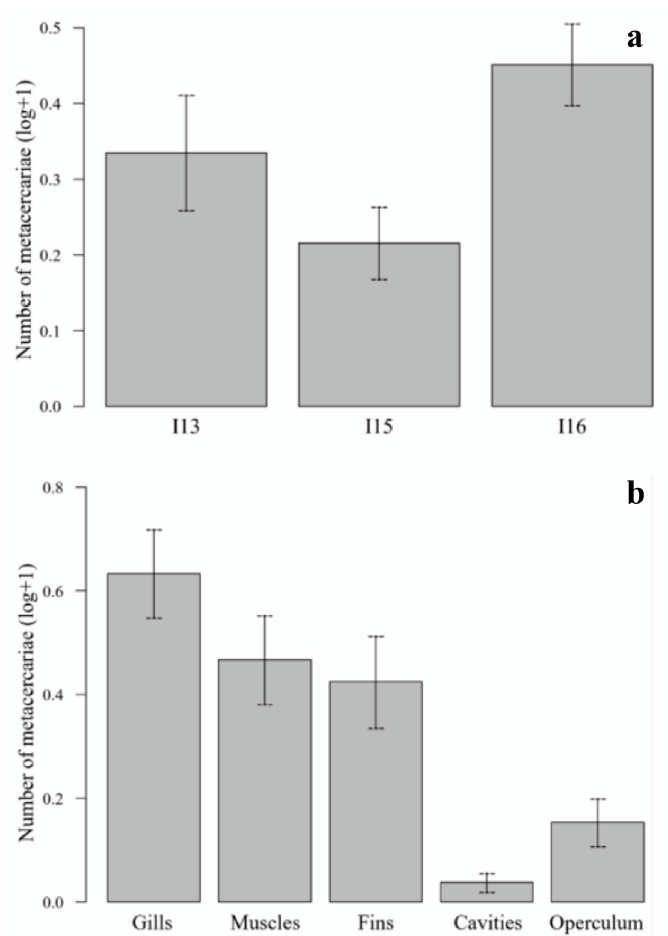
Figure 2(a). Variation in